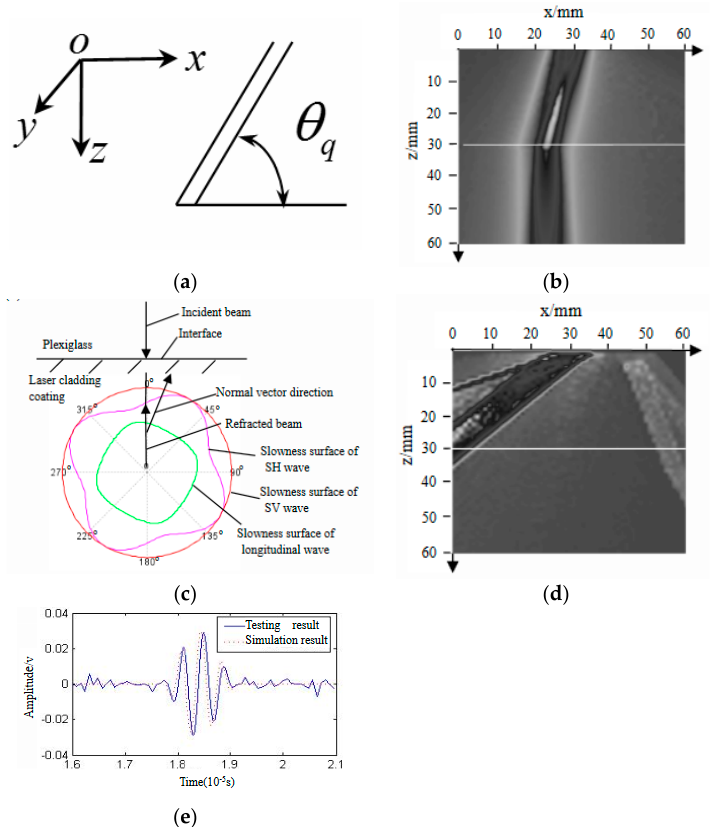
Figure 9. Numerical simulation results [77]. ( a ) The grain orientation angle θ q and direction of the coordinate system; ( b ) The ultrasonic field radiated by a longitudinal wave straight probe in the Fe314 laser cladding remanufacturing specimen; ( c ) Schematic diagram of vertical incident longitudinal wave propagation in Fe314 laser cladding coating; ( d ) The ultrasonic field radiated by a transverse wave angle probe in the Fe314 laser cladding remanufacturing specimen; ( e ) Simulation and testing results of the flaw echo signal in the Fe314 laser cladding remanufacturing specimen. “Reproduced with permission from published by © Springer.” (2016).